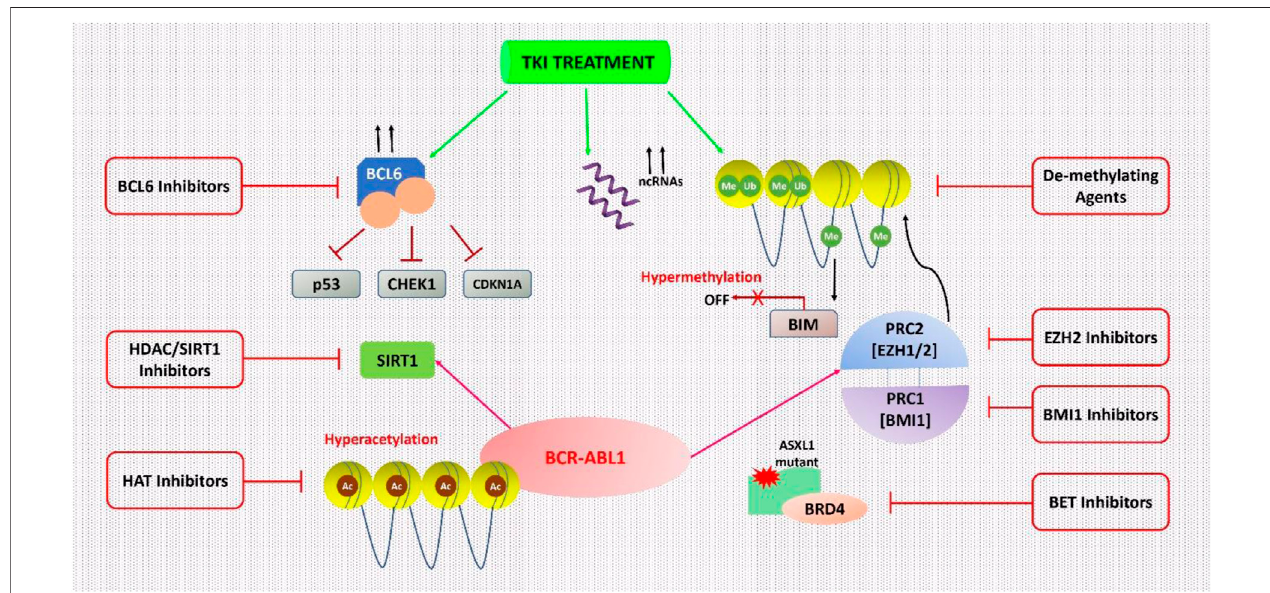
FIGURE 1 | Epigenetic processes in CML cells are being targeted. CML cells are epigenetically reprogrammed via several mechanisms. This dysregulation can occur only in the presence of TKI therapy in various cases. With this understanding, many epigenetic treatments were suggested to inhibit these mechanisms and to result in the complete destruction of CML cells especially in combination with TKI